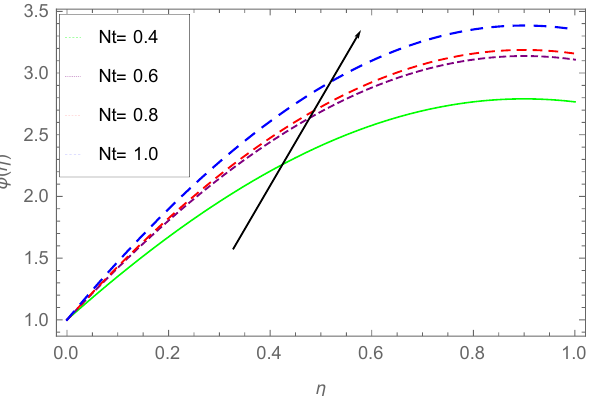
Figure 12. Impact of Nt on φ ( η ) , when Sc = 0.7, (cid:101) = 0.3, β = 0.9, S = 0.5, Nb = 0.5, Pr = 0.6.